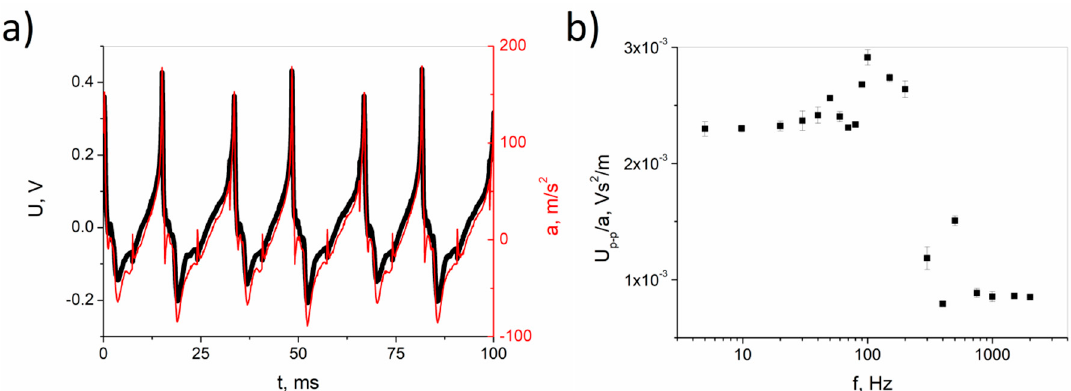
Figure 11. Dynamic loading tests using a shaker with acceleration and generated voltage at a frequency of 60 Hz ( a ), and the frequency response sensitivity of the nanosensor ( b ).